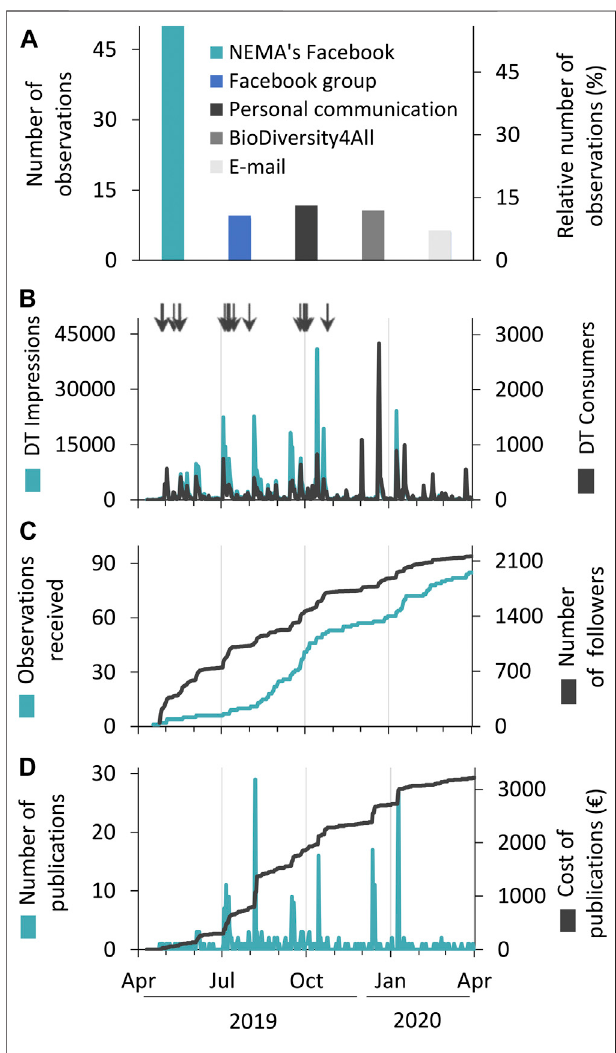
FIGURE 3 | (A) Contribution of each communication platform used by citizens to submit observations of the Atlantic blue crab to NEMA. (B) Facebook metrics between April 2019 and the end of March 2020, namely daily total (DT) impressions and daily total (DT) consumers. (C)